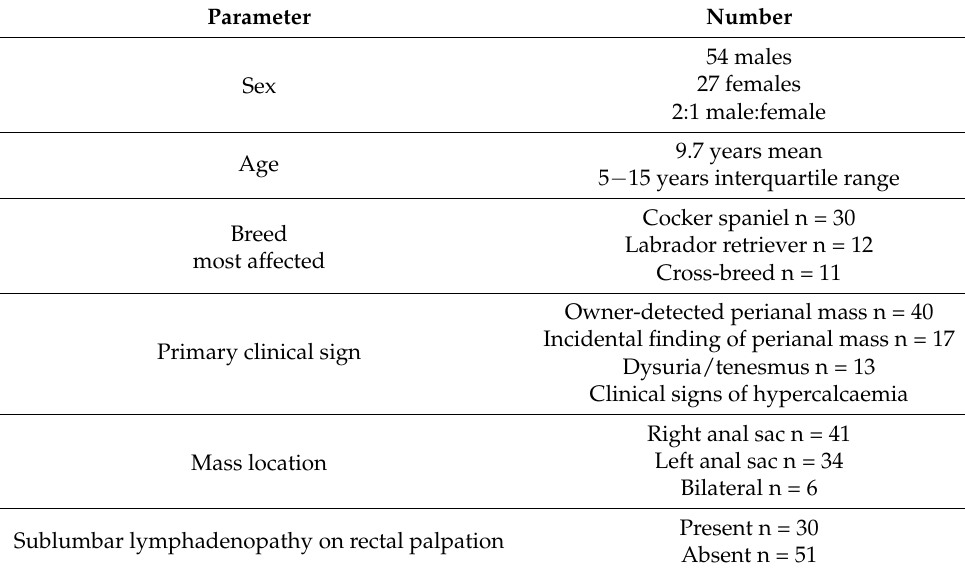
Table 1. Signalment and clinical signs of study